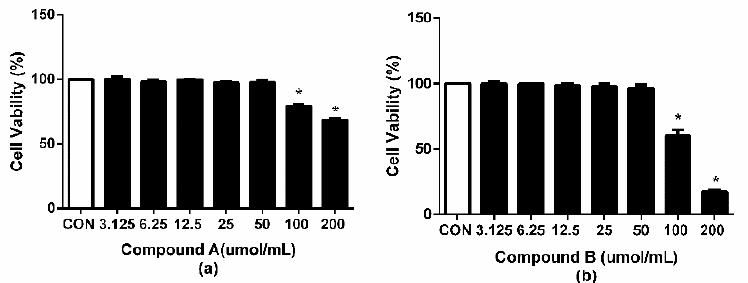
Figure 2. Cytotoxicity of compound A ( a ) and compound B ( b ) in RAW264.7 cells, which were treated with different concentrations of compound A and B for 24 h. * p < 0.05 compared with the control group.